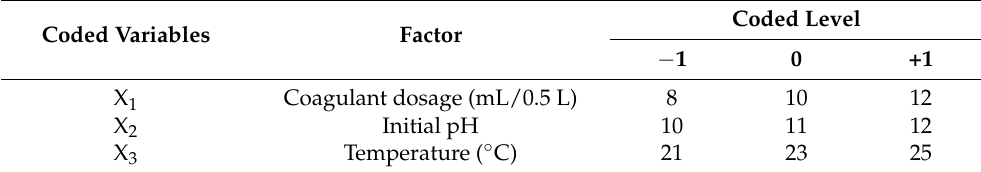
Table 2. Experimental range and levels of independent factors.